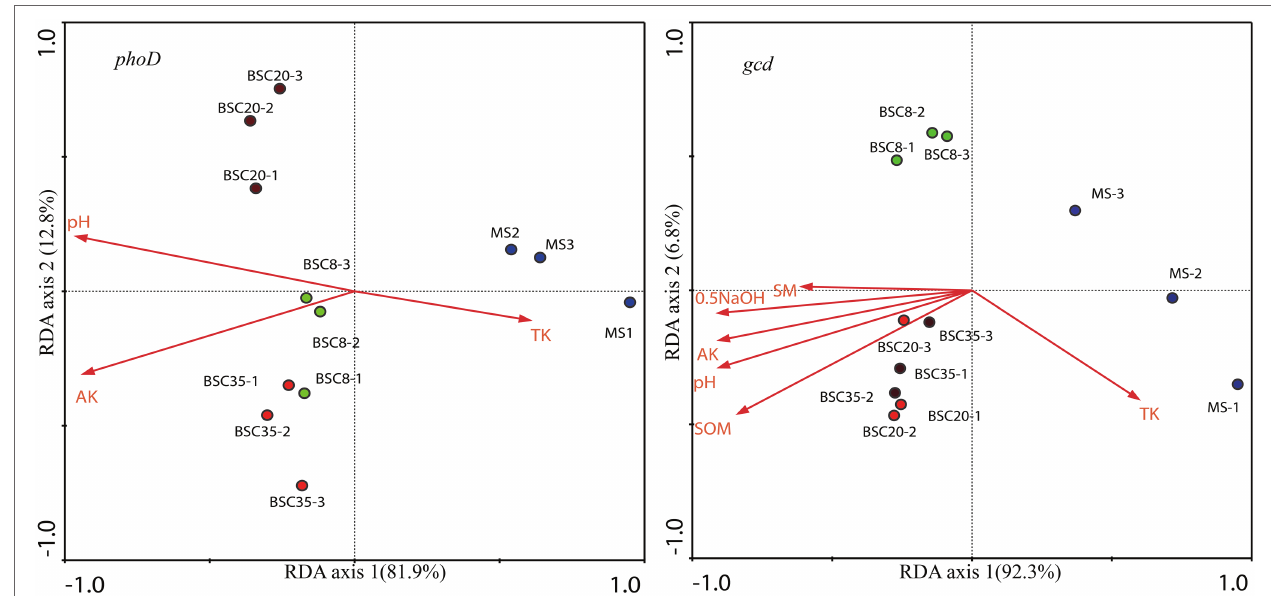
FIGURE 6 | Redundancy analysis (RDA) of the structure of the phoD or gcd community and soil properties. SOM, soil organic matter; TK, total K; AK, available K; SM, soil moisture; 0.5 NaOH, 0.5 M NaOH-Pi; MS, moving sand dune; BSC-8, 8-year-old biological soil crust; BSC-20, 20-year-old biological soil crust; and BSC- 35, 35-year-old biological soil